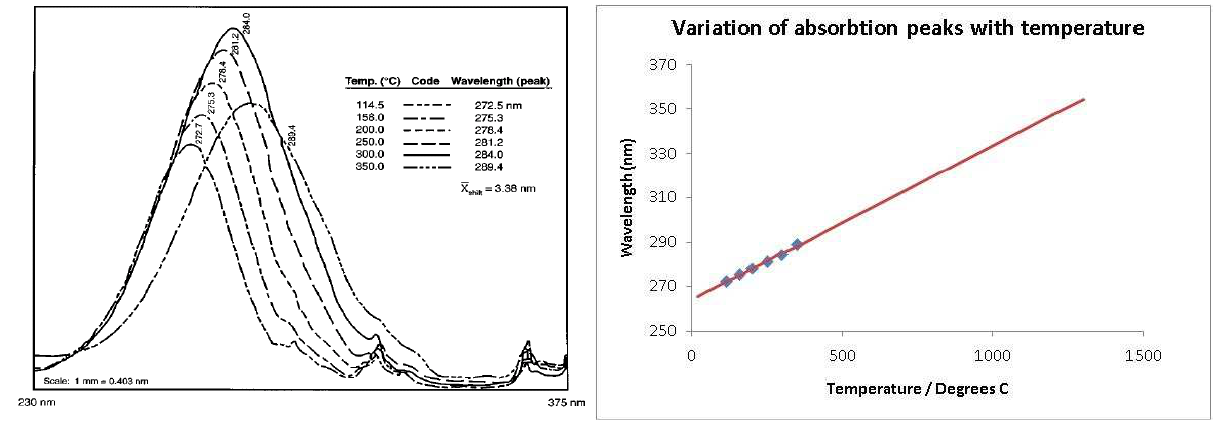
Figure 21 . Left: Variation of absorption peak with temperature [2]. Right: Trend line predicting peak absorption wavelength at higher